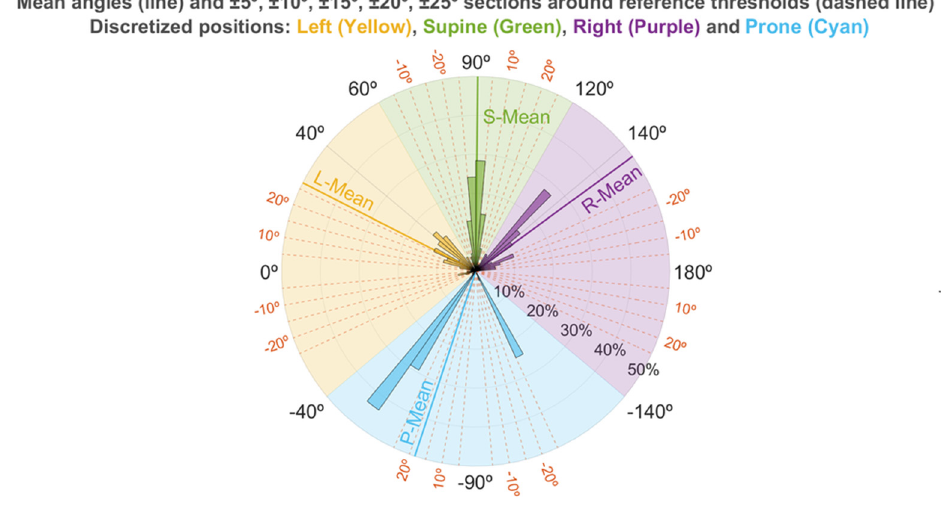
Figure 4. Percentage of minutes found at each sleep angle, classified in 5 ◦ segments, with respect to the total minutes for Figure 4 . Percentage of minutes found at each sleep angle, classified in 5° segments, with respect each position. Mean angles and ± 5 ◦ , ± 10 ◦ , ± 15 ◦ , ± 20 ◦ , ± 25 ◦ windows around the reference angles are also shown. to the total minutes for each position. Mean angles and ±5°, ±10°, ±15°, ±20°, ±25° windows around the reference angles are also shown. Table 5. Sleep angle and stand angle characterization from the automatic smartphone corrected position. The reference angles are 90 ◦ for supine, ± 180 ◦ for right, 0 ◦ for left and − 90 ◦ for prone. Automatic Smartphone Accelerometry Classified by the Discretized Positions Right Supine Left Prone Stand Angle: Mean 143.9 90.6 27.0 166.9 Angle: Standard deviation 14.0 % Angles: Reference angle ± 5 ◦ window